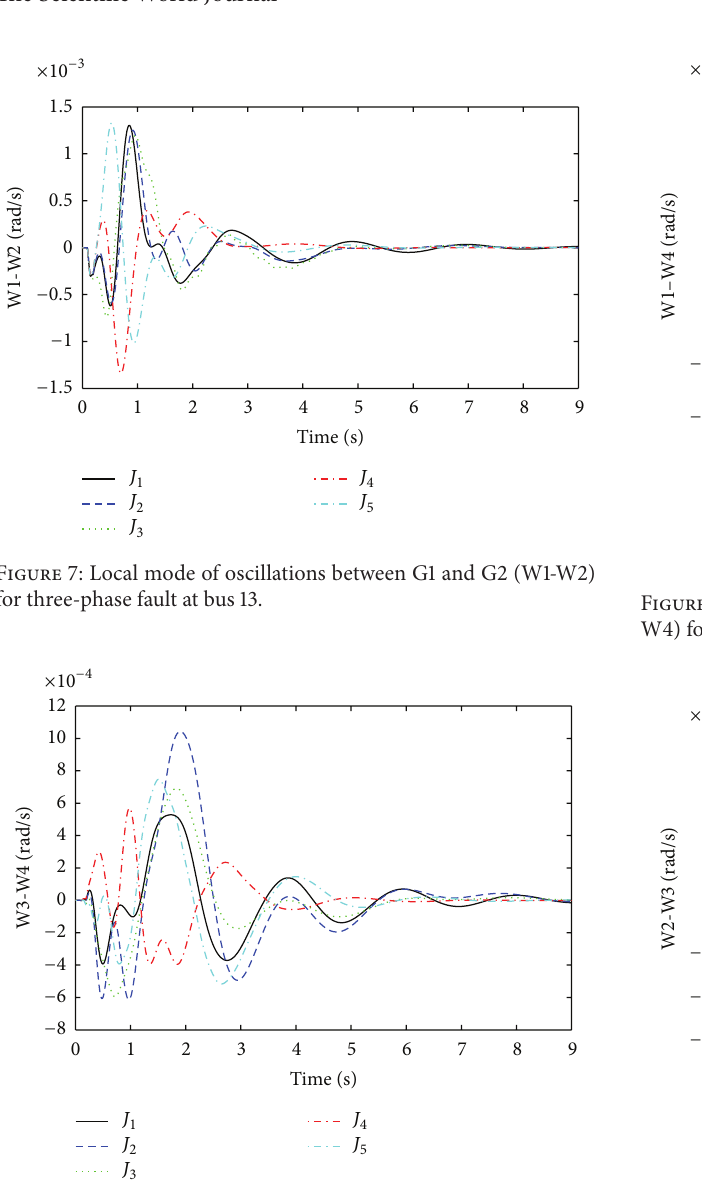
Figure 8: Local mode of oscillations between G3 and G4 (W3-W4) for three-phase fault at bus 13.